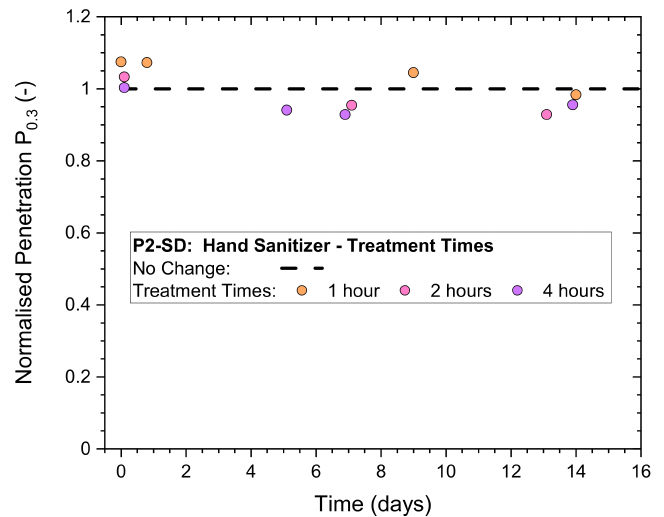
Figure 7. Normalized penetration P n0.3 from whole-mask screening tests of a P2-rated mask (P2-